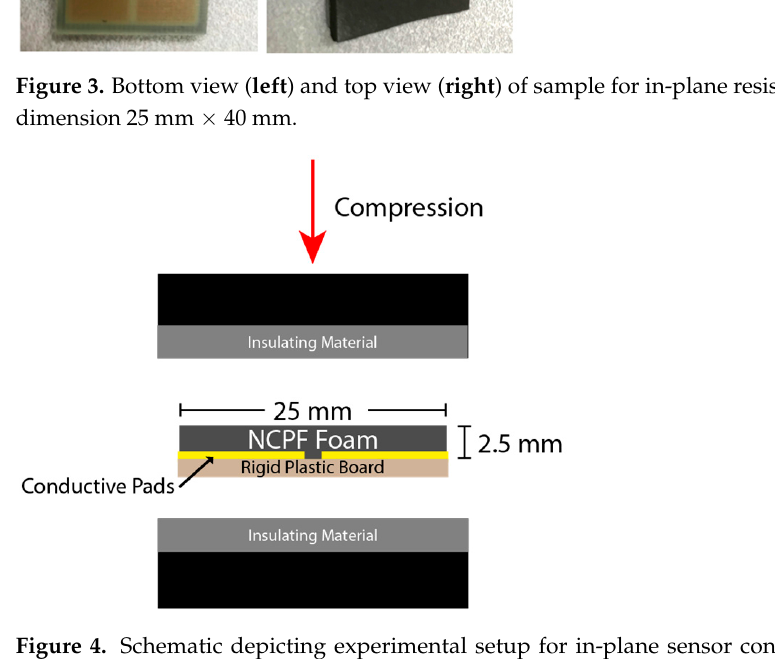
Figure 5. Schematic of sensor connection to oscilloscope/function generator for resistance measure- ments.